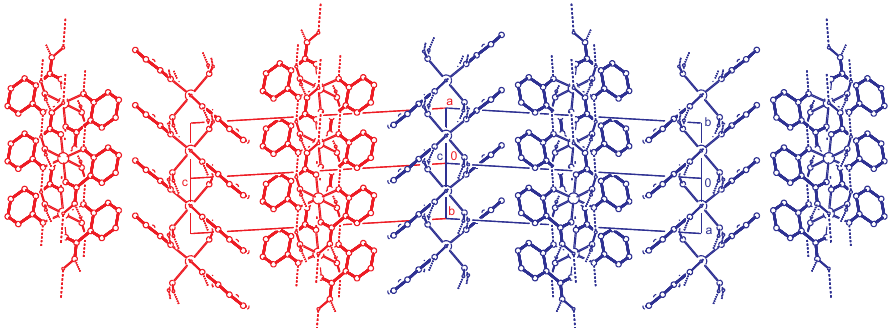
Figure 6. Alternative stacking of the hydrogen bonded layers. Projection along the uvw = [ 110 ] direction. The red and blue unit cells ( P 2 1 / n setting) are related by the twin operation about c ∗ .C-H hydrogen atoms are omitted for clarity.